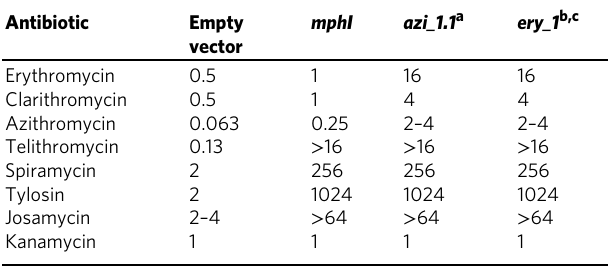
Structural analysis of macrolide recognition by Mph enzymes . To better understand the molecular speci fi city of Mph enzymes against macrolides, we determined the 3-D structure of MphB as the apoenzyme, and three forms of MphH: (1) apoenzyme, (2) in complex with GDP, and (3) in complex with azithromycin (Supplementary Table 4 details of X-ray crystallographic statis- tics). While preparing this manuscript, crystal structures of MphA and MphB were reported in complex with various mac- rolides, which we have included in our analysis of substrate speci fi city 45 . We also attempted to crystallize MphI and MphK as apoenzymes, with several GTP analogs, and with spiramycin, tylosin, and telithromycin, but we were unsuccessful. As expected, the structures of MphB (from our study) and MphH showed that the enzymes adopt the bi-lobe kinase fold reminiscent of APH(2 ′′ ) enzyme crystal structures, with an N- terminal domain dominated by β sheets and a C-terminal domain